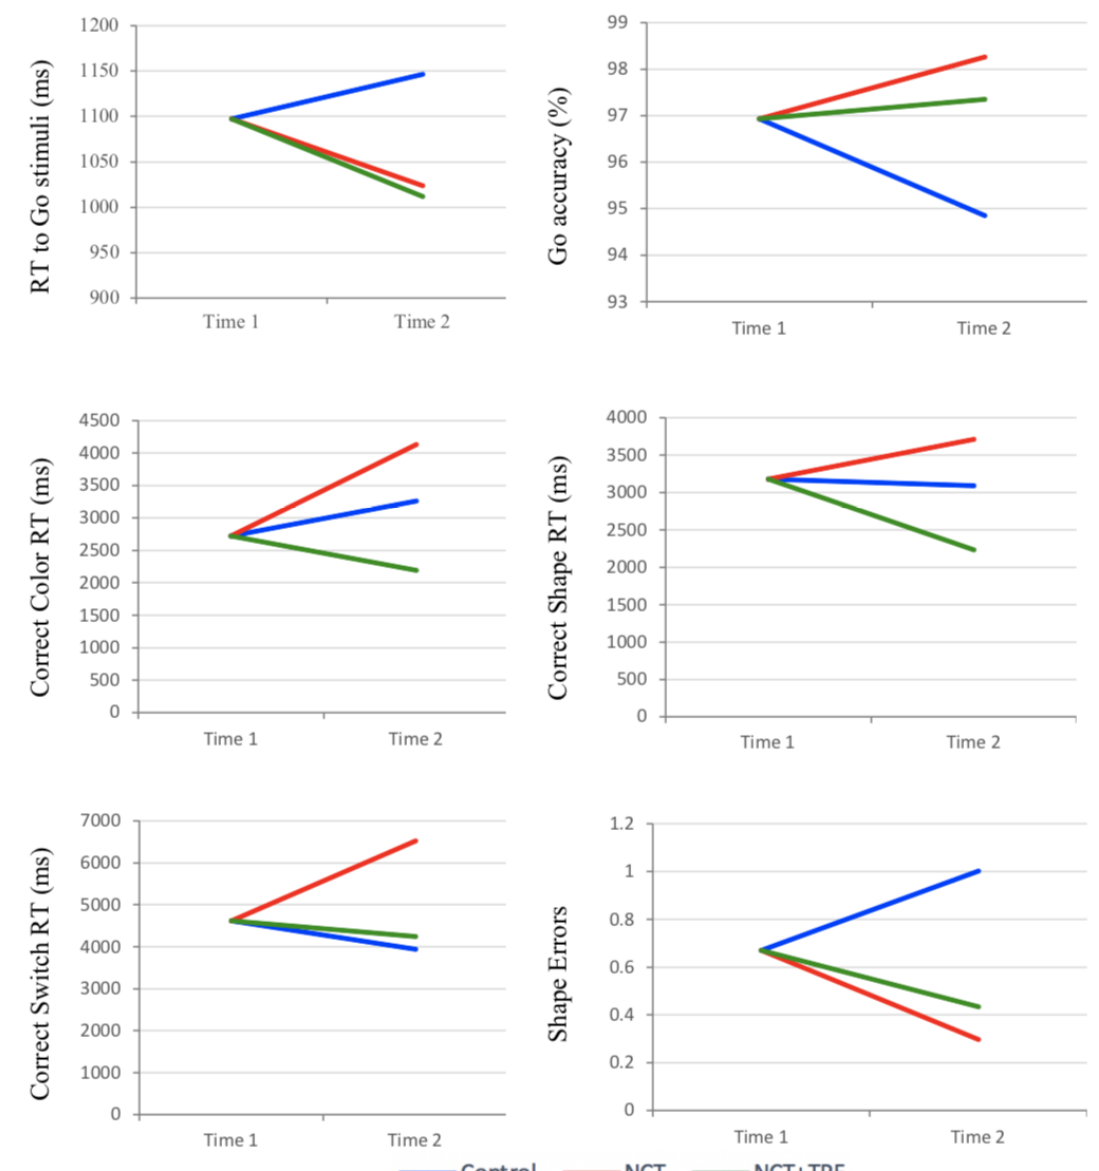
Figure 1. Significant difference at Time 2 with Time 1 as a covariate for RT to Go Stimuli, Go Accuracy, Correct Color RT, Correct Shape RT, Correct Switch RT, and Shape Errors.